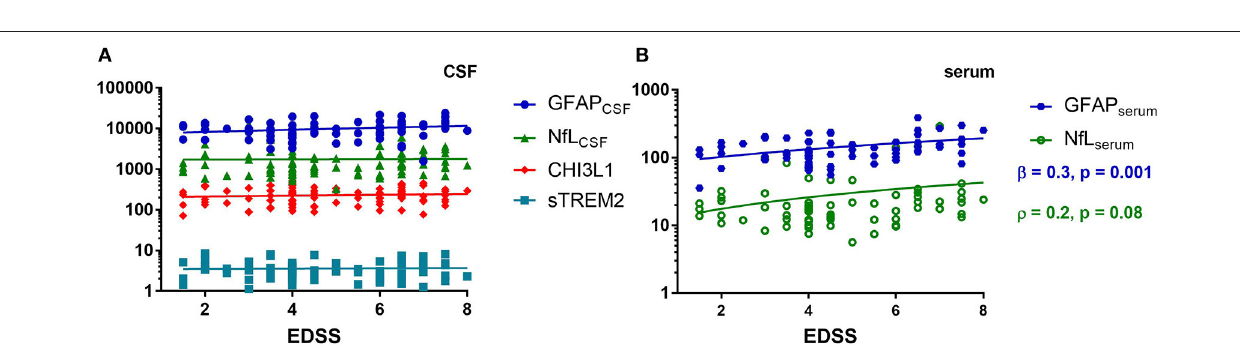
In CSF, NfL correlated with sTREM2 ( ρ = 0.4, p < 0.01,) CHI3L1 ( ρ = 0.3, p < 0.01) and GFAP ( ρ = 0.4, p < 0.001, and Figure 6 ). Moreover, CHI3L1 correlated